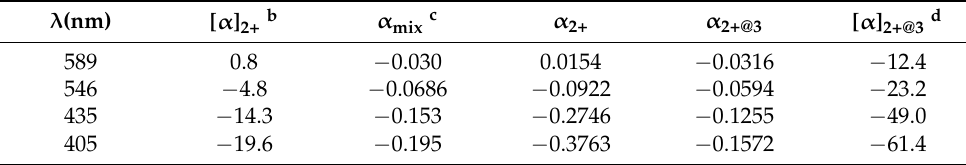
Table 1. Optical rotations of ( endo-chiral )- 2 + @3 pseudo[2]rotaxane a . λ (nm)